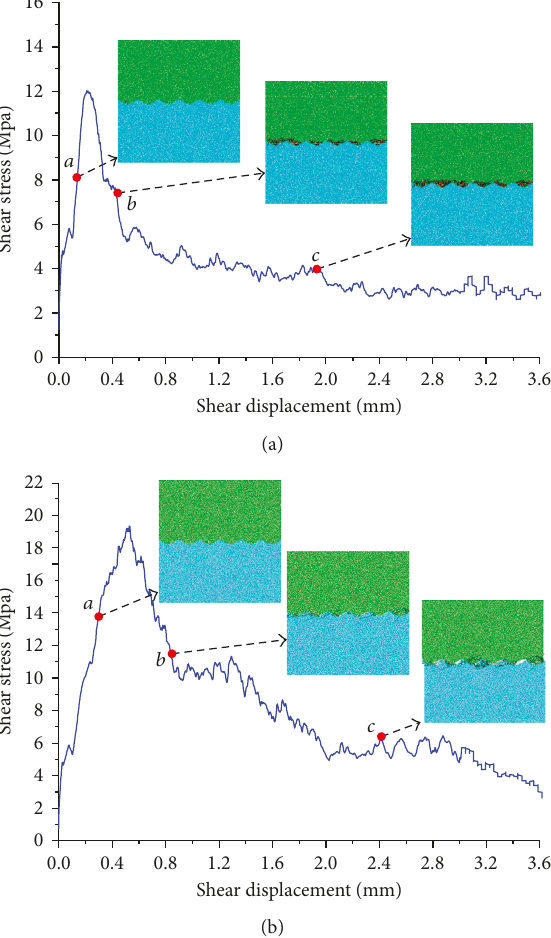
Figure 3: Shear stress and failure process for specimens with different bond strength ratios and normal stresses: (a) bond strength ratio of 0.25 and normal stress of 3.0MPa; (b) bond strength ratio of 1.0 MPa and normal stress of